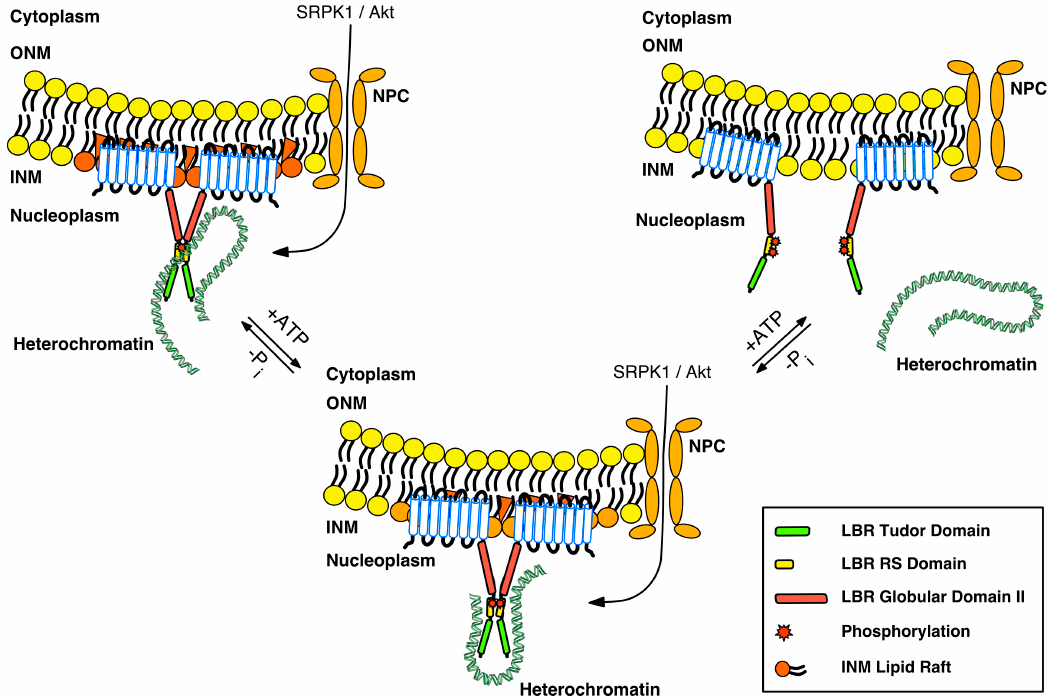
Figure 3. A provisional model for the LBR–heterochromatin interaction. LBR exists in oligomers that reside in distinct microdomains embedded within specific INM lipid rafts. LBR is mainly unphosphorylated and associates with heterochromatin through its tudor (green box) and RS (yellow box) domains. The second globular domain (red box) may also contribute, to some extent, to heterochromatin association via HP1. Activation of SRPK1 and/or Akt kinases, combined with their nuclear translocation due to various stimuli, modifies the oligomerization state of LBR, and accordingly, its binding to various partners of the LBR complex. We hypothesize that at the same time, the composition of LBR-associated lipid rafts also changes, either as a direct effect of phosphorylation or via other signals that regulate the sterol reductase activity and may or may not be related to phosphorylation. These concomitant alterations result in chromatin rearrangement and altered gene expression. Hyperphosphorylation of LBR by SRPK1 and Akt (and cdk1 at the beginning of mitosis) results in the dissociation of oligomers that are no longer embedded in lipid rafts, and the consequent dissociation of heterochromatin. “Free” LBR molecules exhibit an increased diffusional mobility throughout NE–ER.